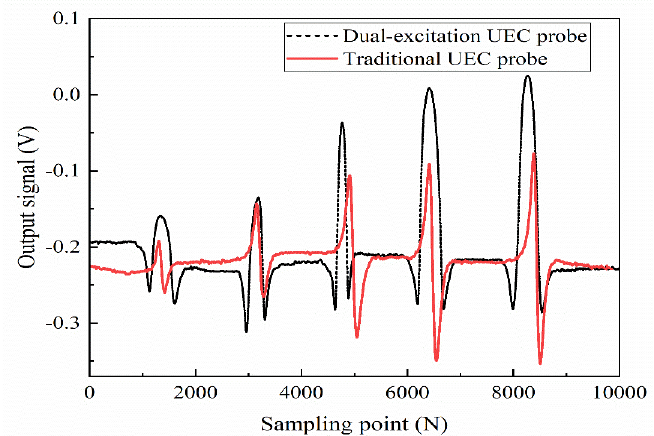
Figure 13. Test signals of the two UEC probes for crack defects with different